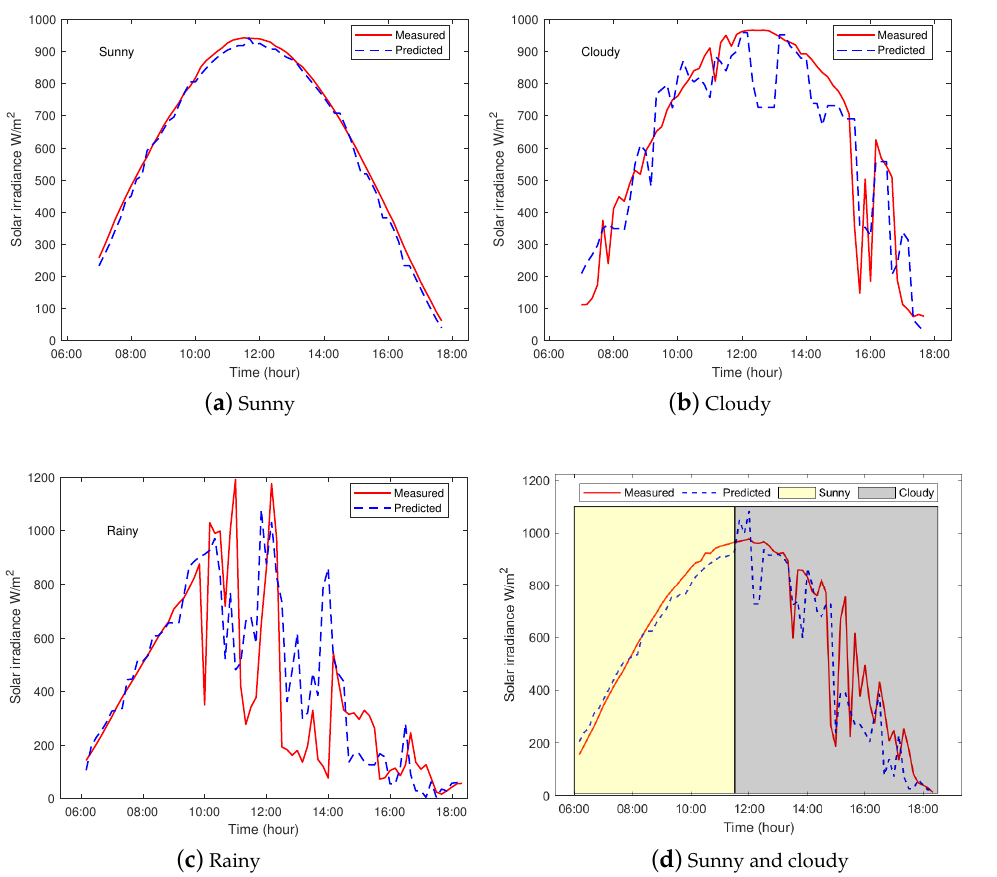
Figure 7. Measured vs. forecasted hourly solar irradiance for three types of weather